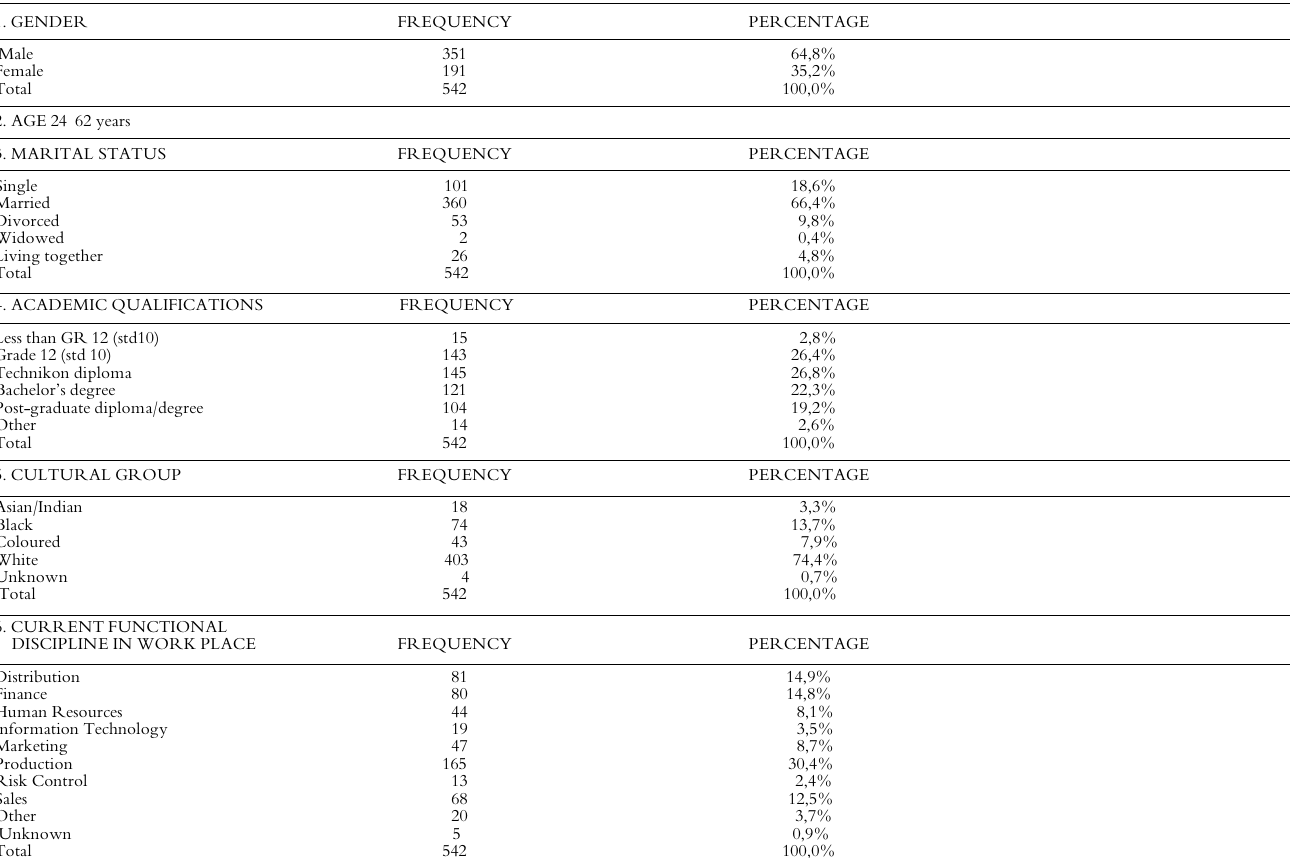
TABLE 1 BIOGRAPICAL INFORMATION OF THE